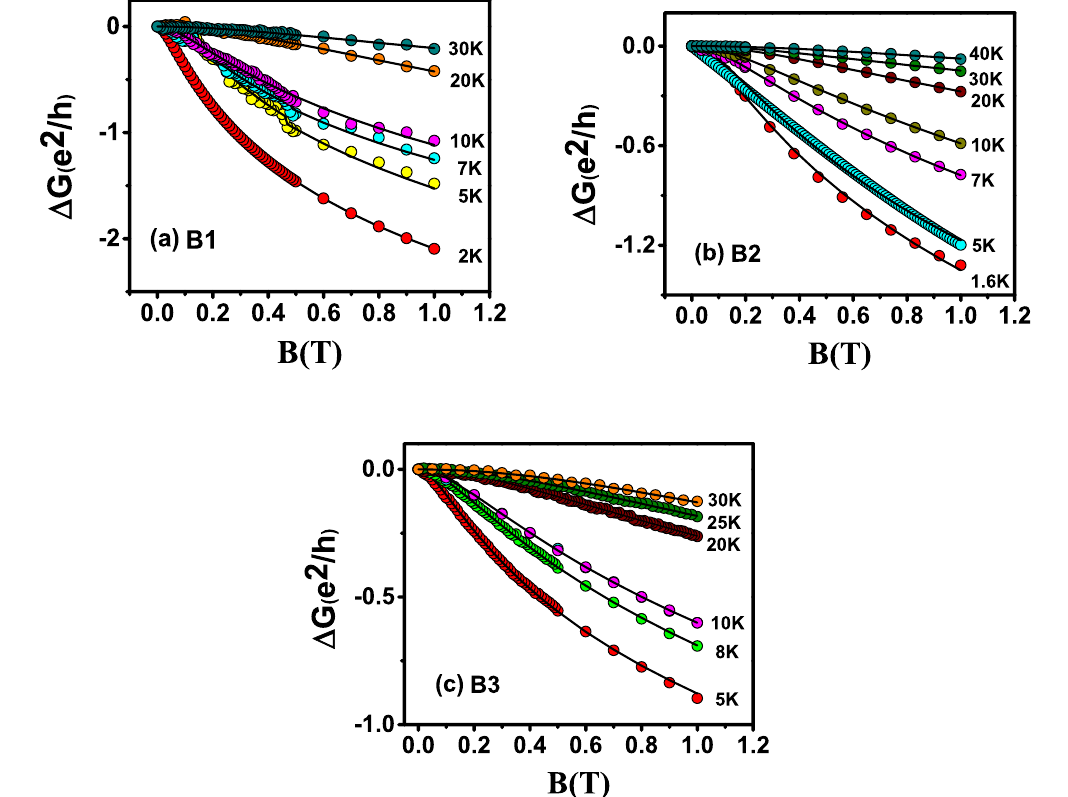
Figure 4. HLN fit of conductance data at different temperatures of samples B1, B2 and B3.